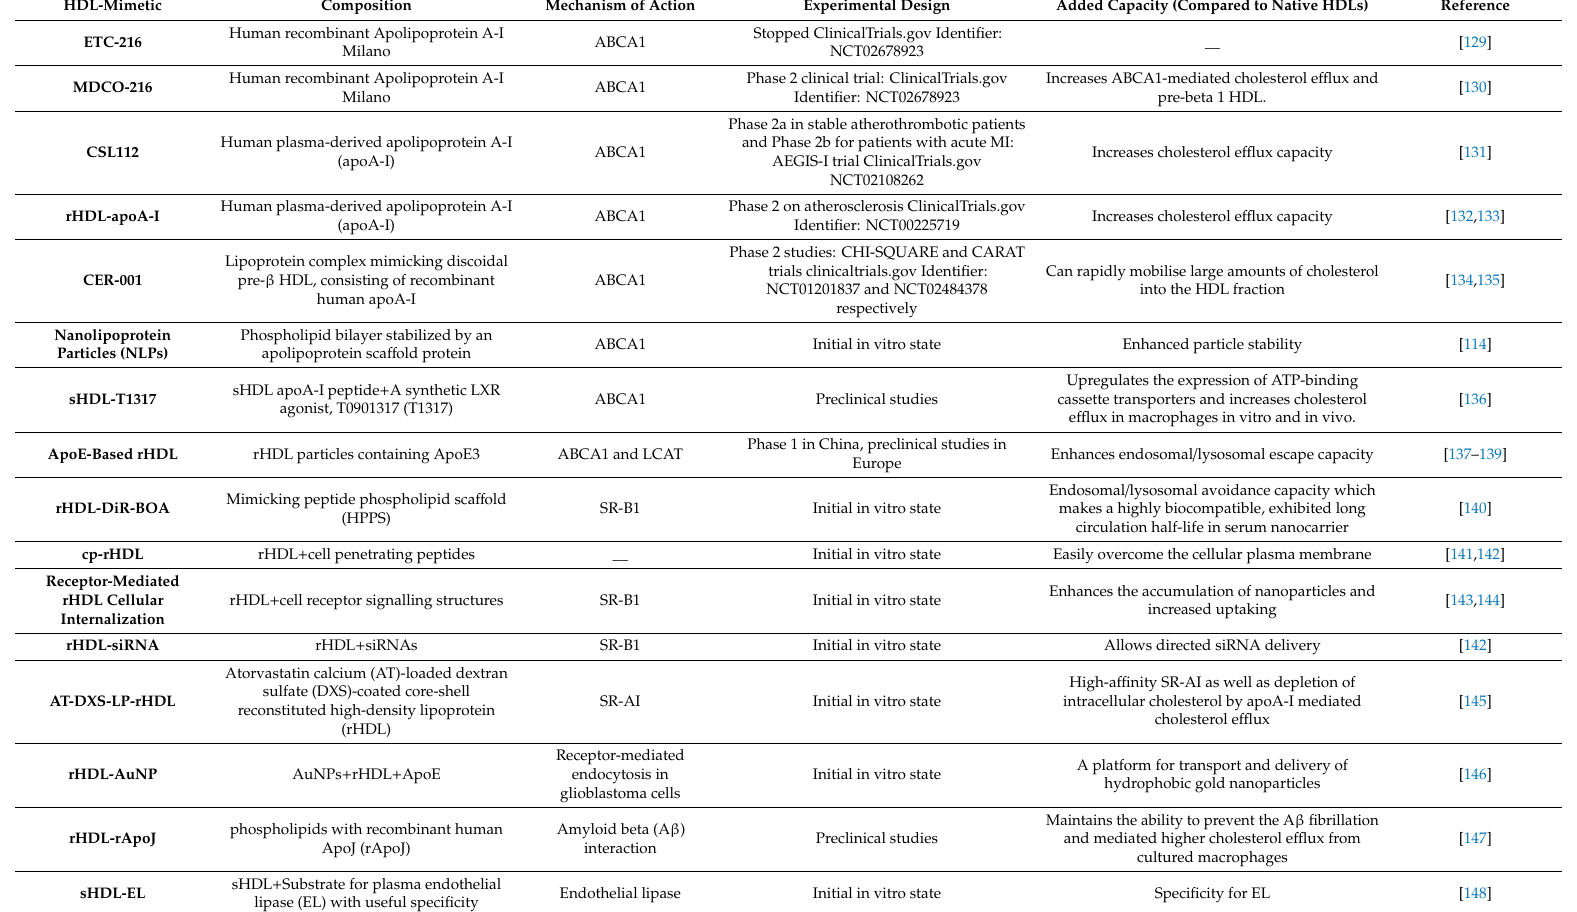
Table 1. HDL synthetic-based